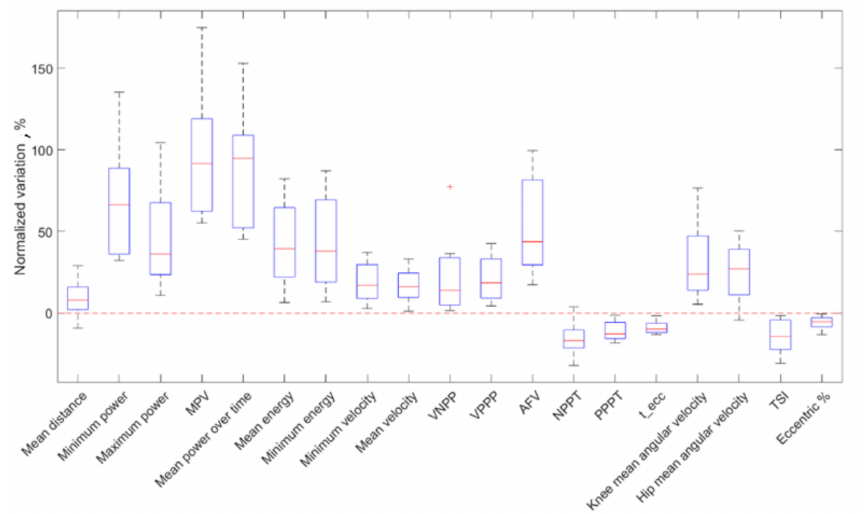
Figure 7. Normalized variations for all the parameters of the PAP